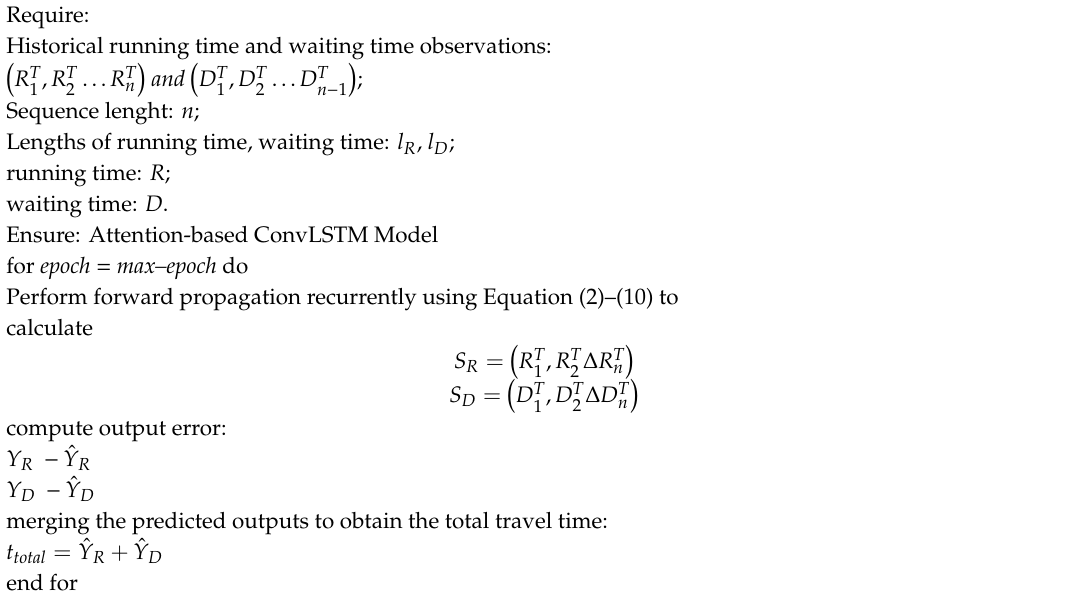
Algorithm 1 Attention-Based ConvLSTM Training